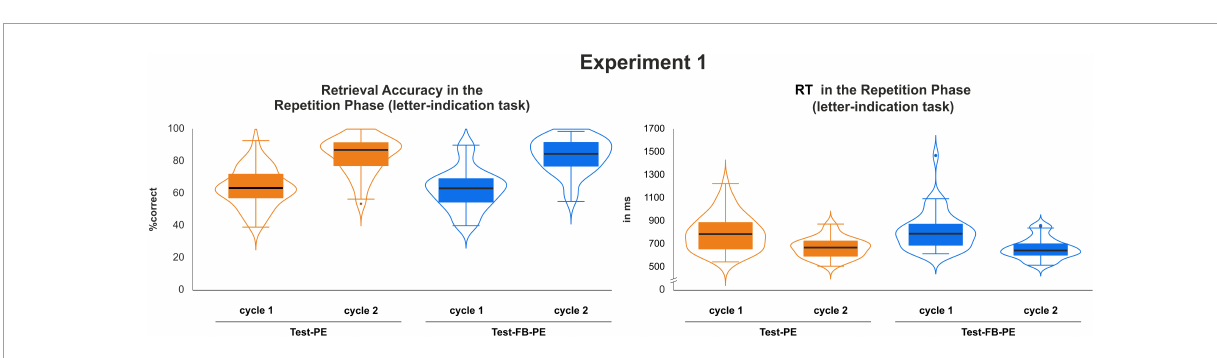
FIGURE4 Retrieval accuracy and RT results during repetition cycle 1 and 2 with as a function of repetition practice (Test-PE vs.